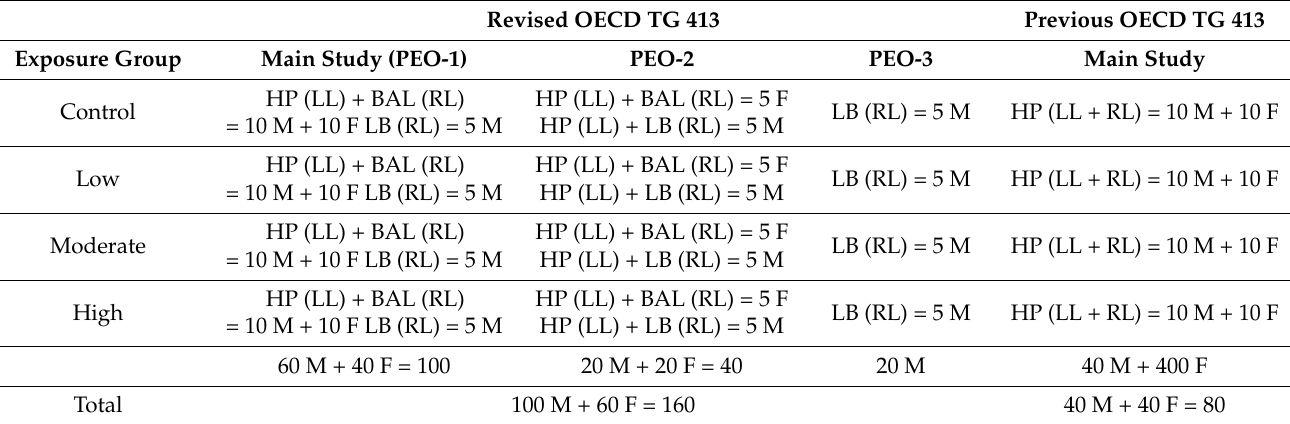
Table 2. Study design for TG